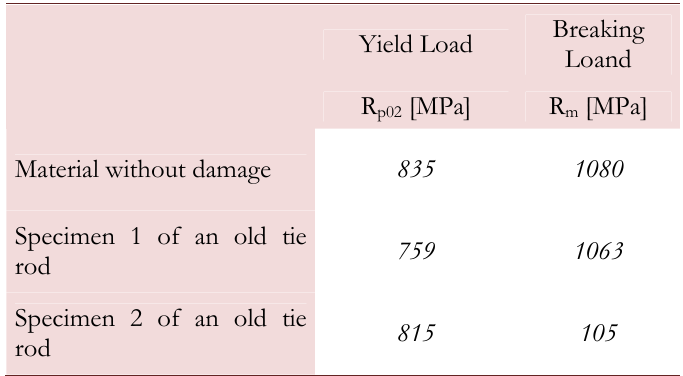
Table 5: Results of Static Test.